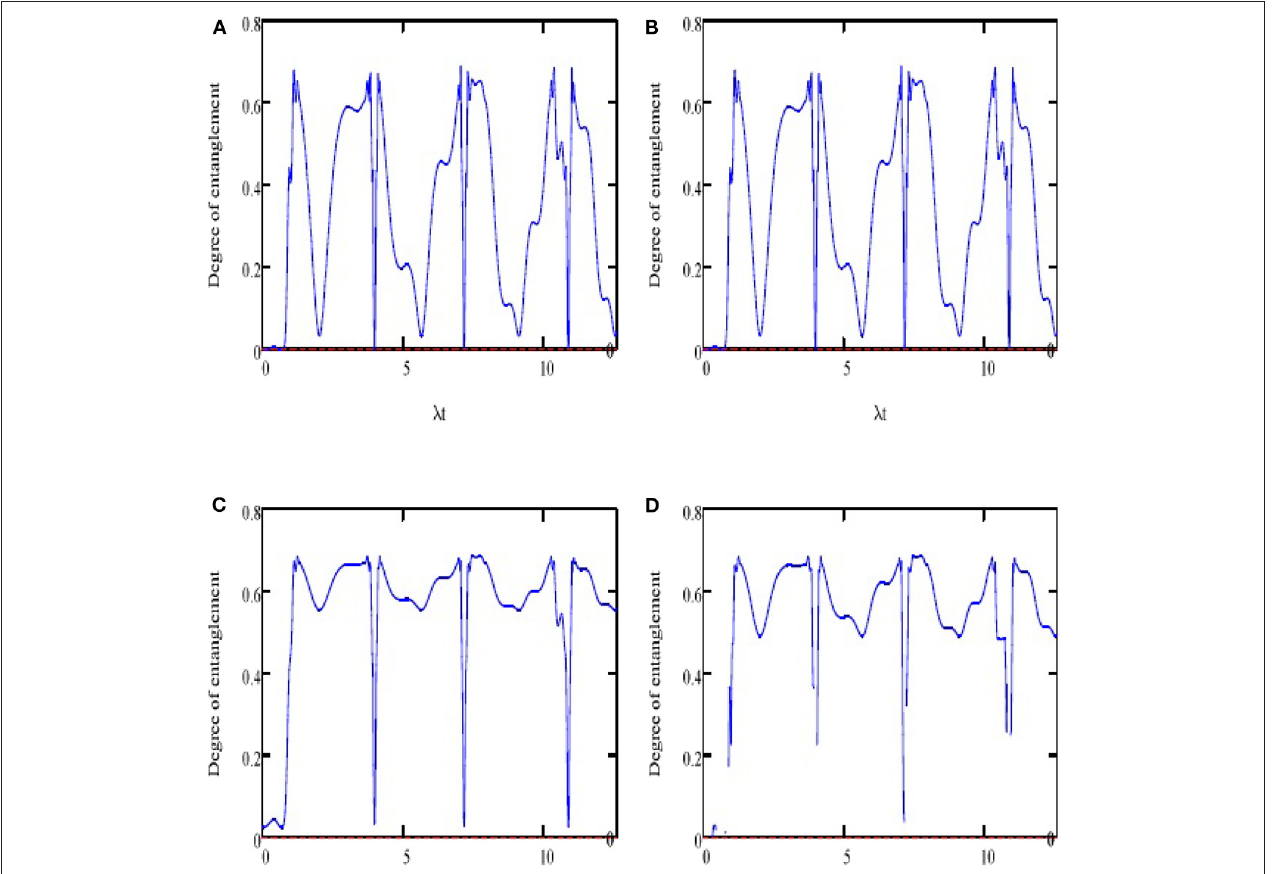
FIGURE 2 | (A–D) Variation of degree of entanglement quantified by the ANE for with the same parameters and conditions as in Figure 1 .